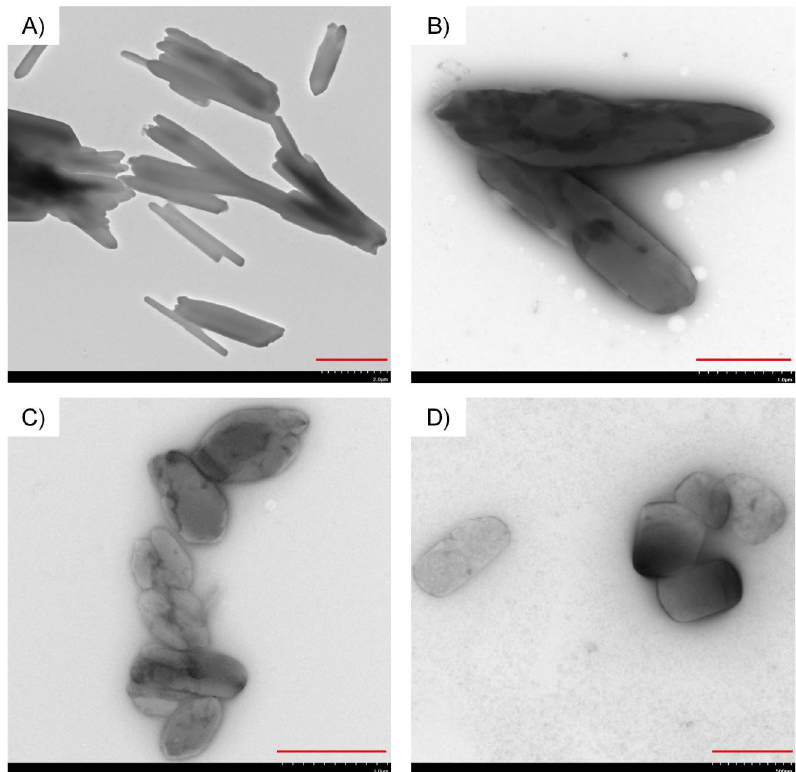
Figure 10. Scanning electron microscopy ( SEM) images of raw, unprocessed cilostazol powder ( A , B ), microcrystals ( C , D ) and nanocrystals ( E , F ). ( A ) magnification 1500×, scale bar 50 µm; ( B ) magnification 5000×, scale bar 20 µm); ( C , E ) magnification 10,000×, scale bar 10 µm; ( D , F ) magni- fication 30,000×, scale bar 4 µm.